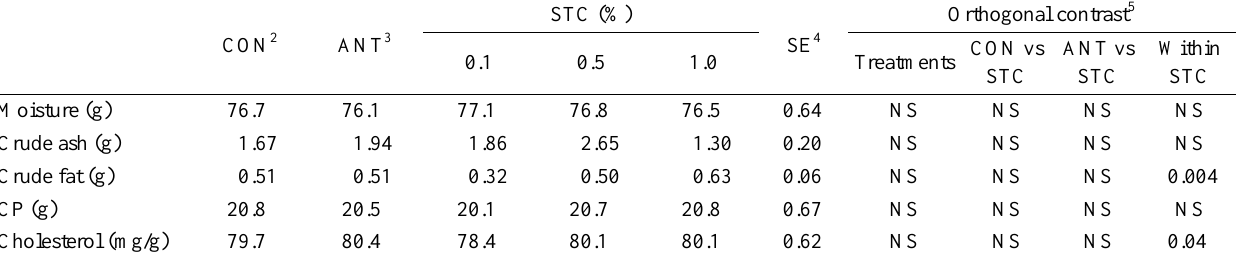
Duck breast muscle composition